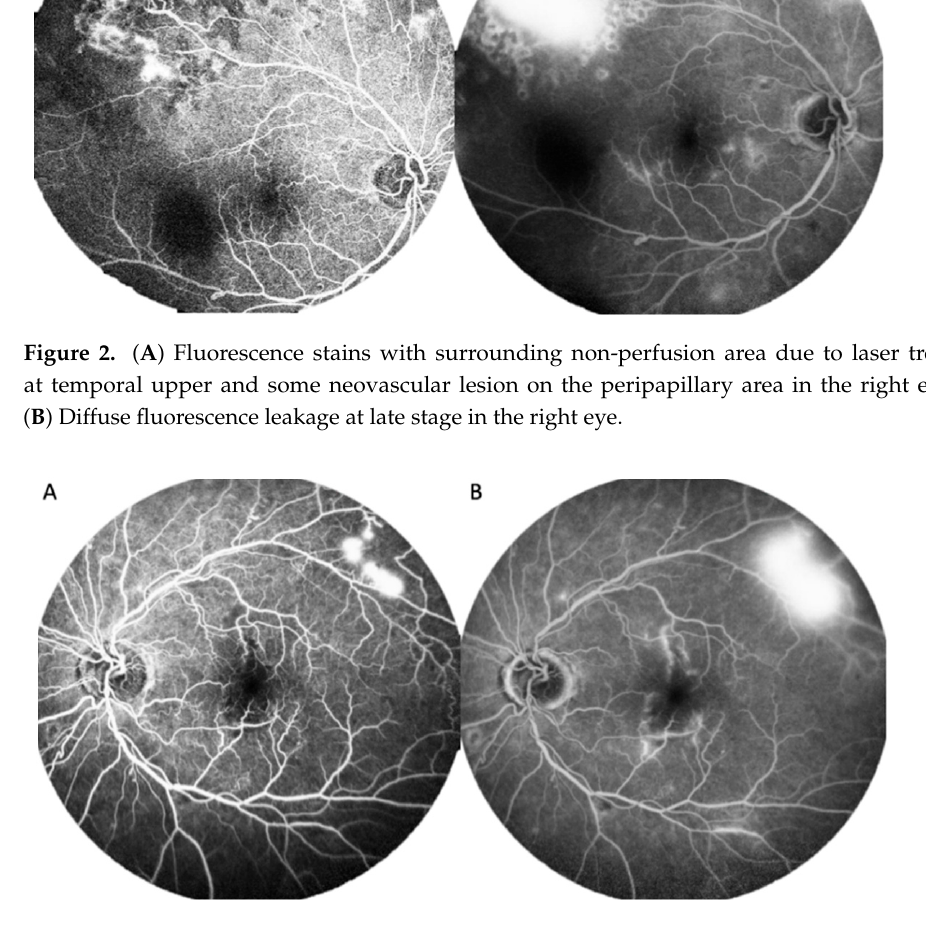
Figure 4. ( A ) Tortuous retinal artery and venous sheathing in the right eye; ( B ) Fibrovascular mem- brane with hemorrhage surrounded with laser scar in the right eye; and ( C ) Tortuous retinal artery in the left eye. Figure 5. ( A , B ) No additional neovascular lesion or fibrovascular membrane formation in both eyes after two years follow up.